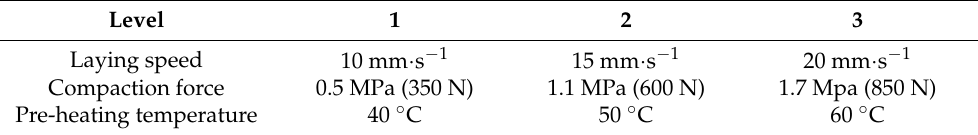
Table 2. Experimental